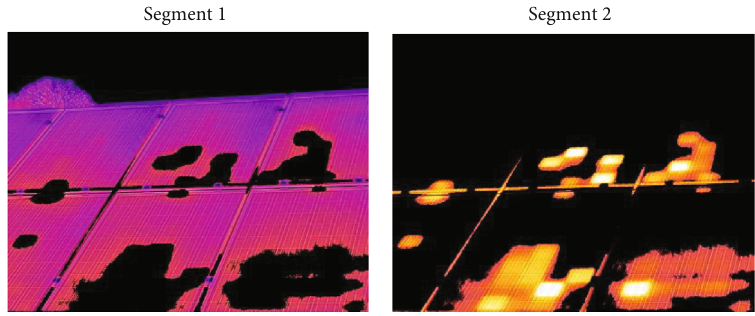
Figure 10: Output results using K-means algorithm for k = 2 .